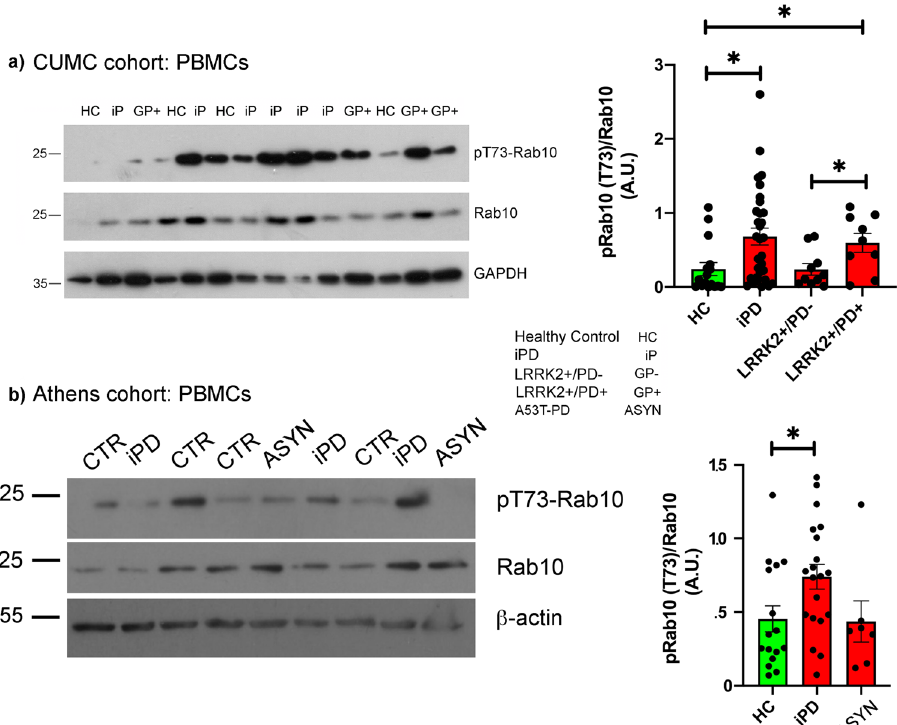
Fig. 1 Phosphorylation of Rab10 is elevated in PBMCs from idiopathic PD and affected carriers of the G2019S mutation in LRRK2. Extracts of PBMCs from the indicated subject groups were separated by SDS-PAGE and probed for phosphorylated (T73) and total Rab10, as well as GAPDH. a Representative western immunoblots showing pT73-Rab10 and total Rab10 from PBMCs of the CUMC cohort; with the quanti fi cation of the band intensity shown to the right. ANOVA was performed to identify signi fi cant differences between groups, with Tukey ’ s post-foc tests. * p < 0.05. b PBMC extracts were separated by SDS-PAGE. A representative western immunoblot probed for pT73-Rab10 and total Rab10 from PBMCs of the Athens cohort; with the band intensities quanti fi ed and presented in the panel to the right. For normalization, the band intensity of pT73-Rab10 was then normalized to total Rab10. Error bars in all data plots represent SEM. ANOVA was performed to identify signi fi cant differences between groups, with Tukey ’ s post-foc tests. * p <